Question: Provide a one-line summary of what is displayed.
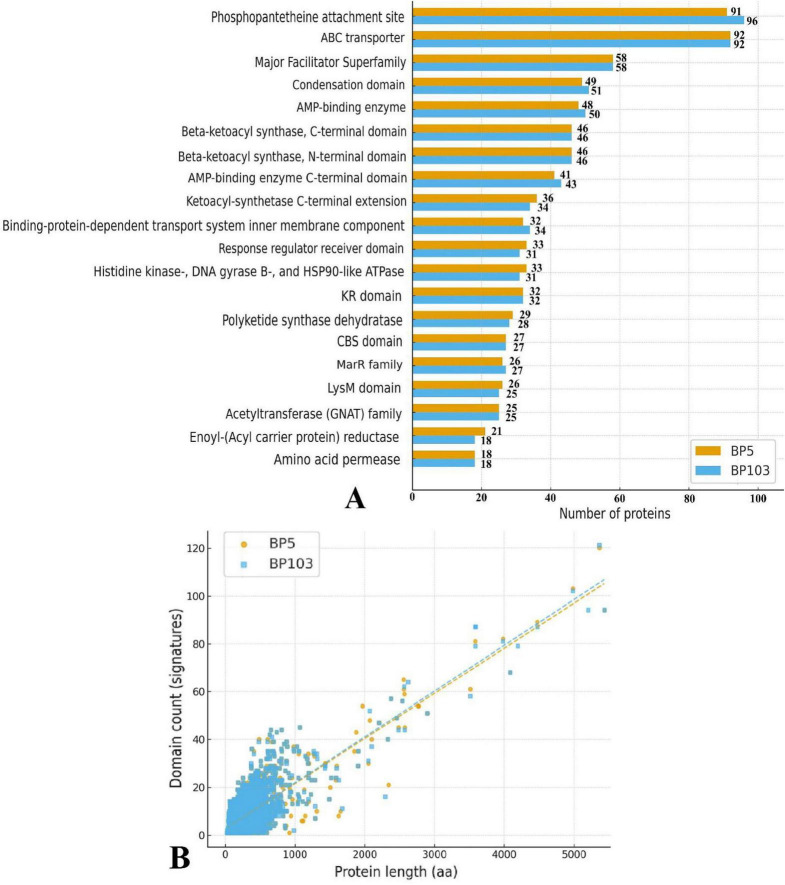
Answer: Protein domain characteristics between B. velezensis BP5 and BP103. (A) Comparison of Top 20 Pfam Domains between B. velezensis BP5 and BP103. (B) Scatter Plot Comparing Protein Length and Domain Count in BP5 and BP103.